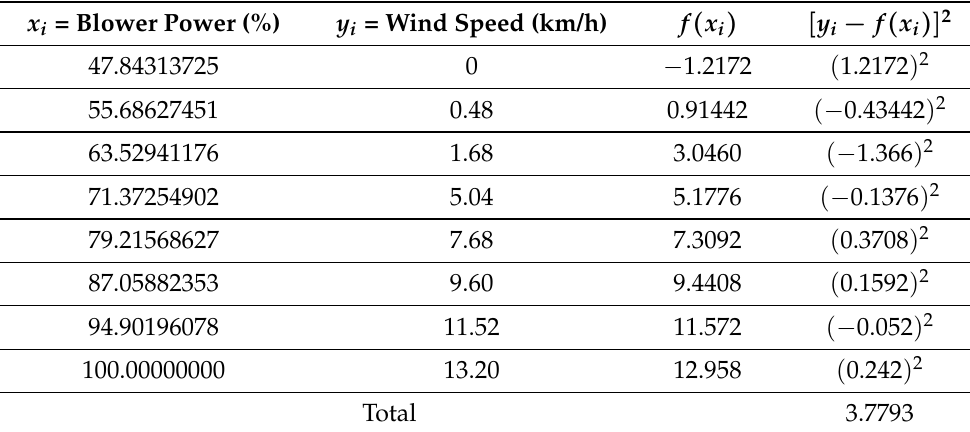
Figure 16. Instructional design: abstract level. Table 2. Sum of squared